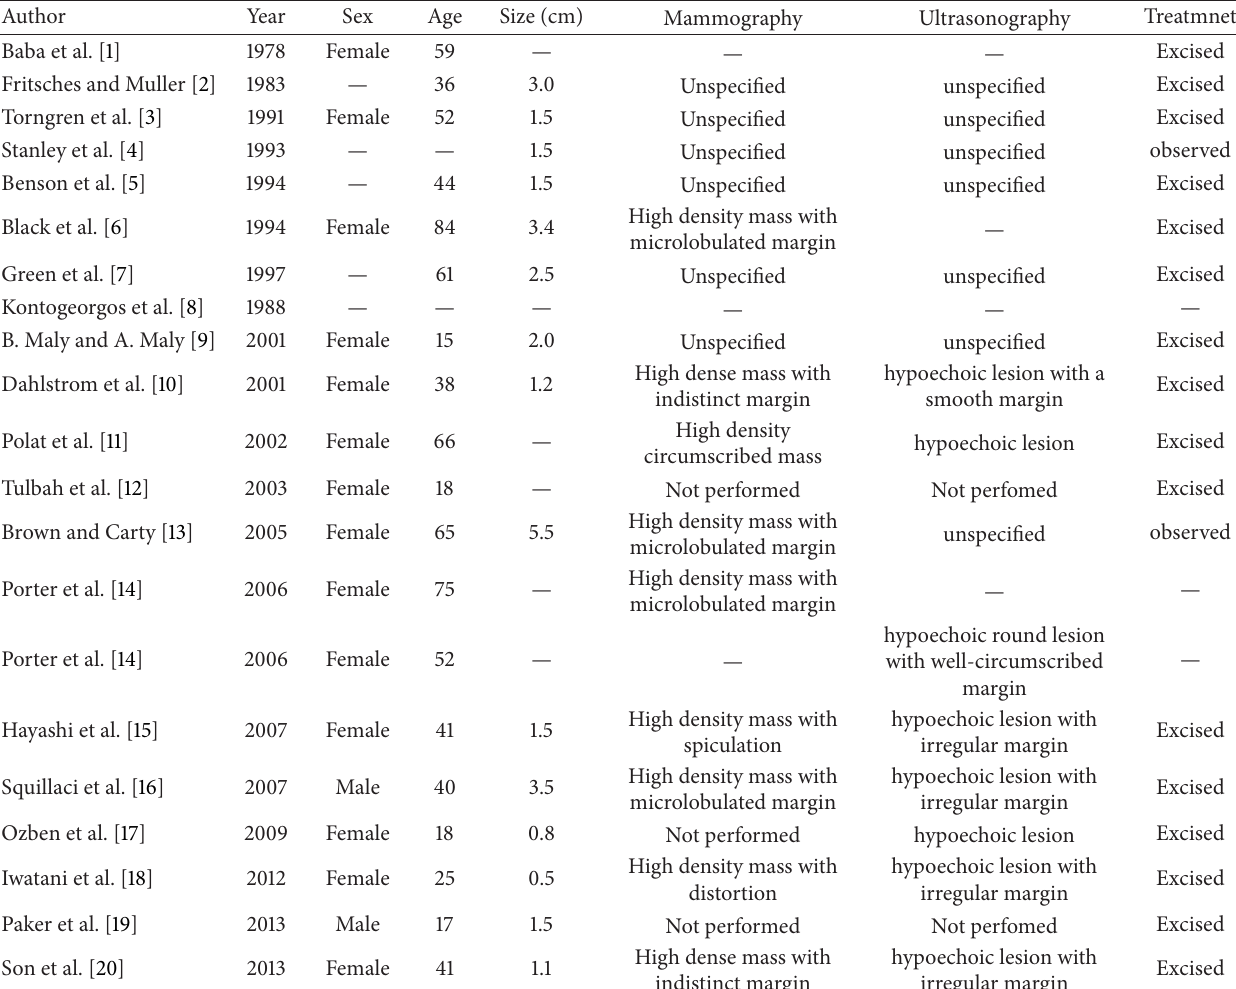
Table 1: Reported cases of nodular fasciitis in the